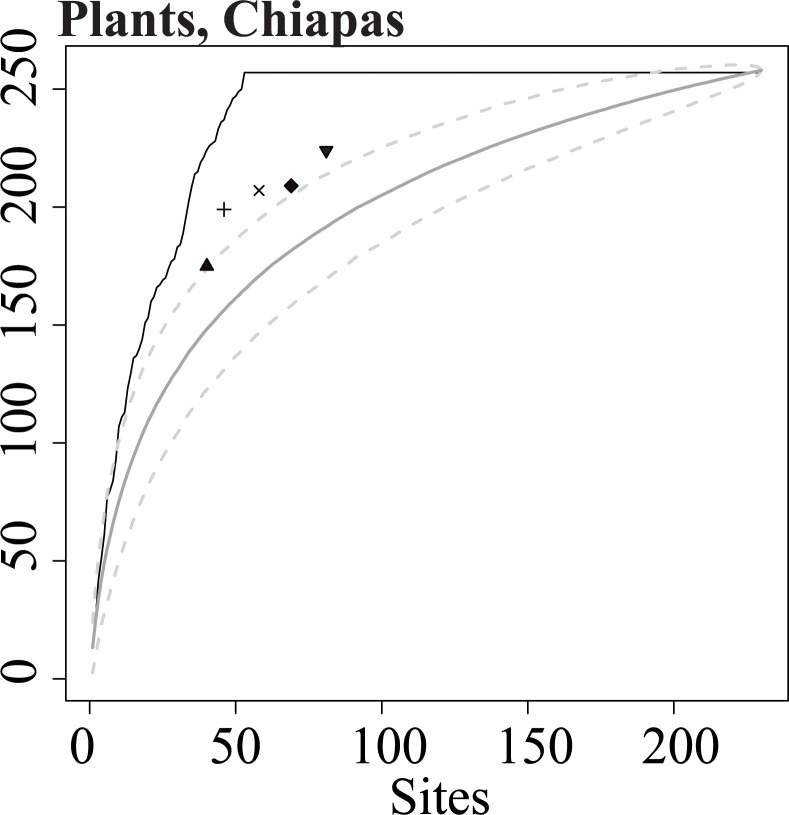
A full species accumulation curve for plants in Chiapas.The upper line (black) indicates the largest possible number of species represented at least once in a given number of sites, as estimated by Zonation [22]. The lower curve (gray) indicates the average number of species represented at least once in a randomly-selected set of sites; dashed lines enclose 95% of 1000 random sets. Symbols represent the number of species represented at least once in sites selected to maximize β diversity (dispersion of sites in a 2-dimensional ordination of species assemblages). From left to right, the symbols correspond to 15% (upward triangle), 20% (cross), 25% (x), 30% (diamond), and 35% (downward triangle) of all sites in the dataset. In Fig 2, data in the lower left portion of the graph are omitted to present the same results in higher resolution.